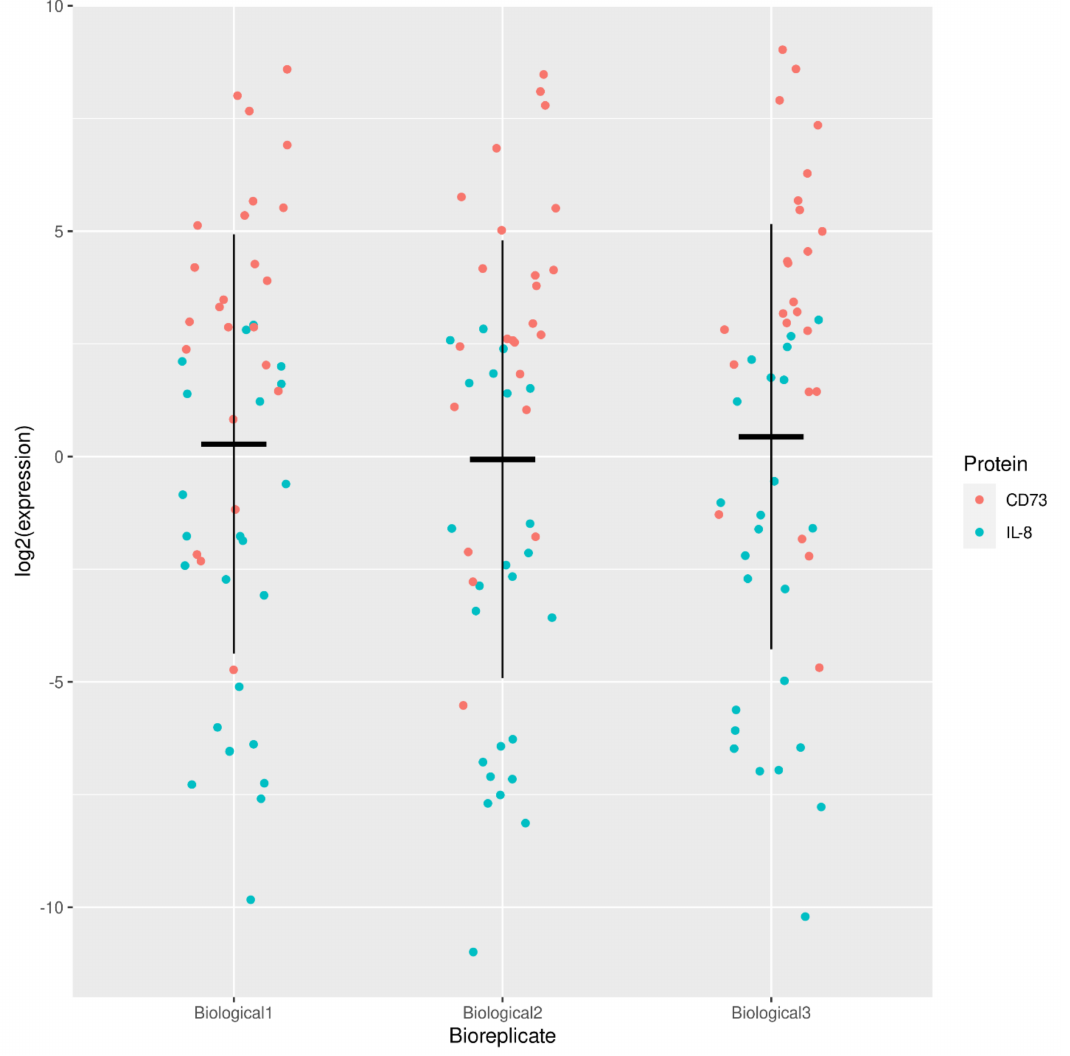
Figure 4. Strip plot showing the log2 expression of IL-8 and CD73 for the three biological replicates for all